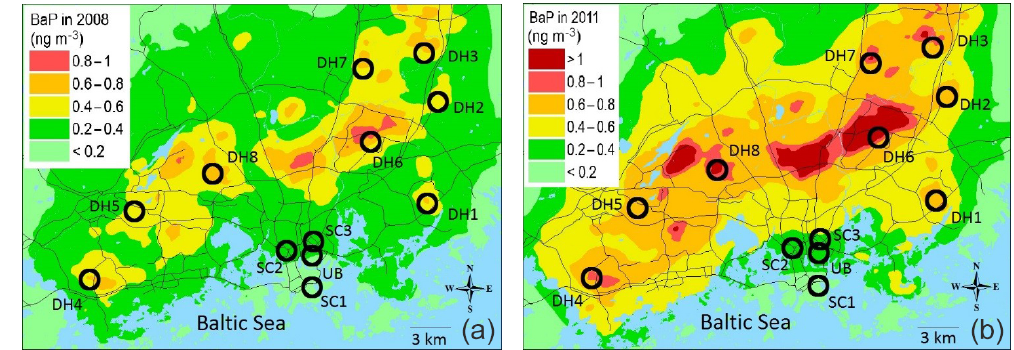
Figure 6. The predicted spatial distributions of the annual average concentrations of BaP originating from wood combustion in the Helsinki metropolitan area in 2008 (a) and 2011 (b) . Influence of the regional and long-range transported background is not included in the values of these figures. The main road network is shown for